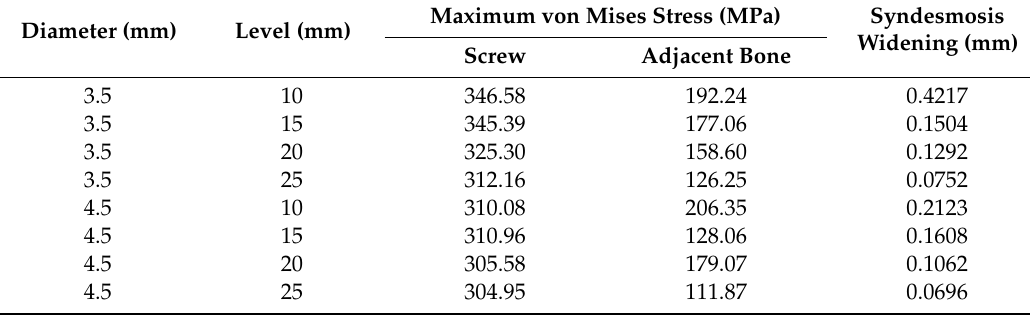
Table 8. Maximum von Mises stresses and syndesmosis widening: stainless steel screw with four cortical bones